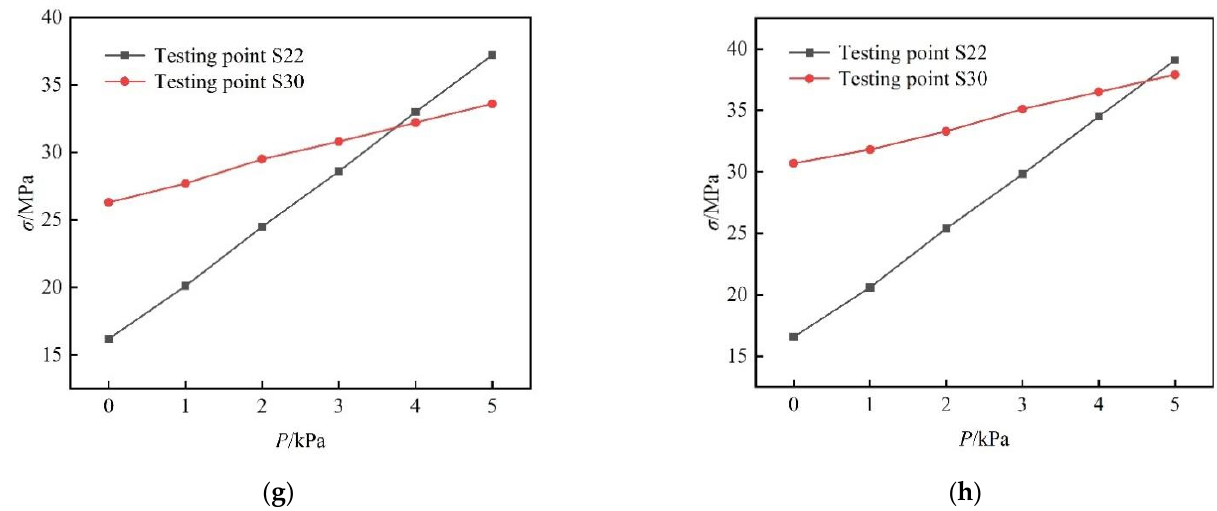
Figure 8. Coupling stress versus uniform load curves. ( a ) SJ1; ( b ) SJ2; ( c ) SJ3; ( d ) SJ4; ( e ) SJ5; ( f ) SJ6; ( g ) SJ7; ( h ) SJ8.